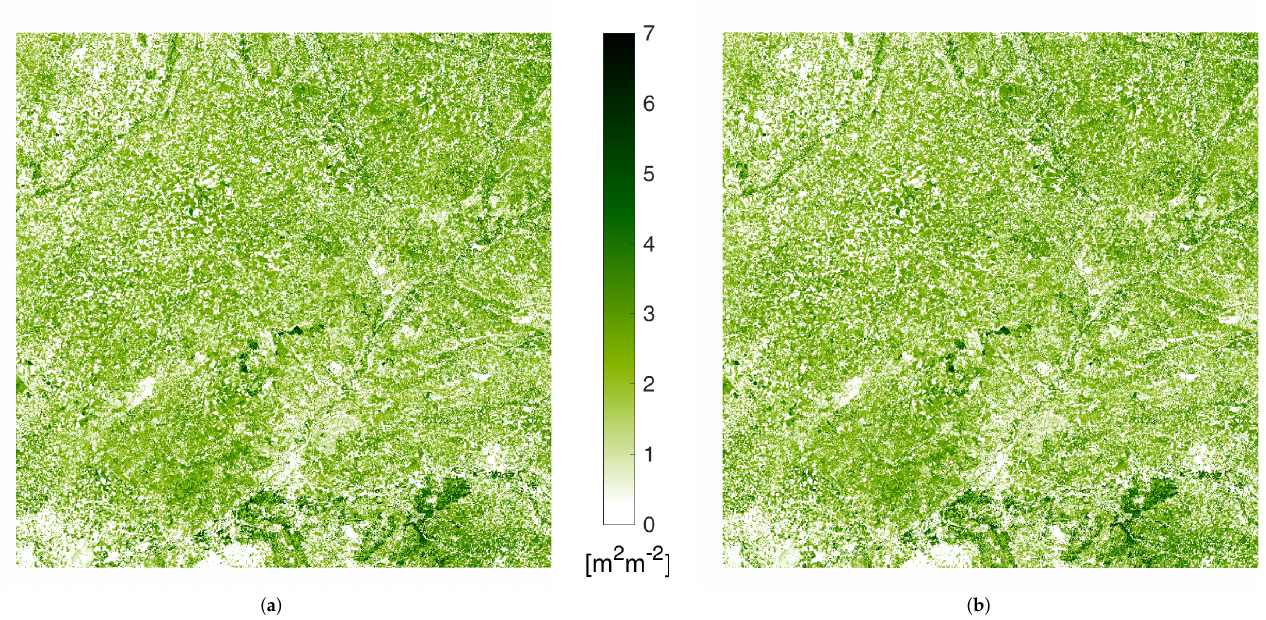
Figure 2. Comparison between green LAI maps retrieved by Automated Radiative Transfer Models Operator (ARTMO) ( a ) and GEE GPR coding ( b ) from S2 acquisition over tile 30TUM on 2 May